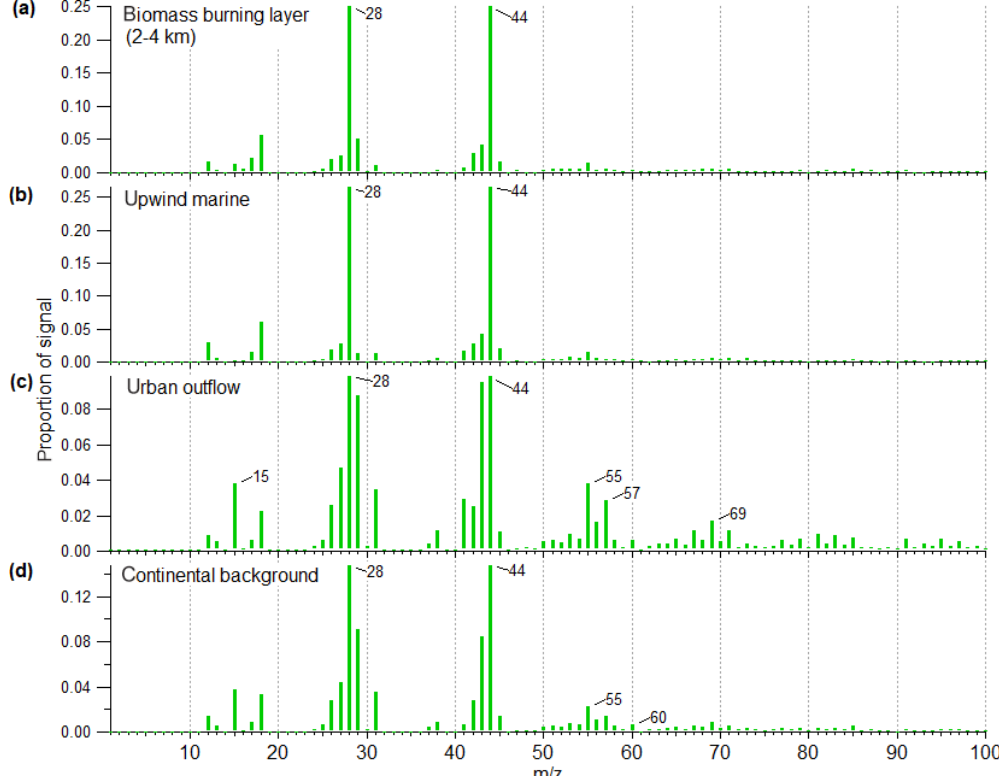
Figure 5. Average organic aerosol mass spectra in (a) the 2–4km biomass burning layer (from the Falcon AMS) and (b–d) each of the three regimes (ATR and Twin Otter). The influence of fresh urban emissions can be seen in the urban outflow regime and, to a lesser extent, in the continental background, demonstrated by the higher proportion of m/z 55 and 57, alongside larger hydrocarbon clusters. Fresh biomass burning is indicated by the peak at m/z 60. However, the dominant contribution in all cases is from m/z 28 and 44, both indicators of aged, oxidised organic